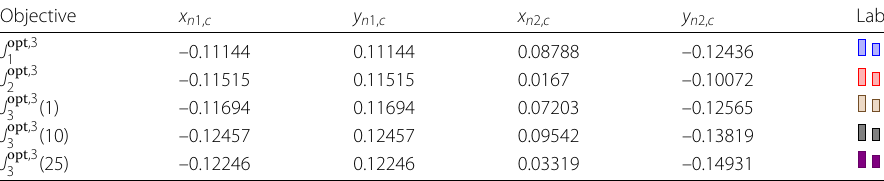
Table 6 Optimization of nozzles’ positions. Computed weighted centers (equation (9)) for the used objective functionals on level 3. The labels correspond to the configurations in Fig. 9 Objective